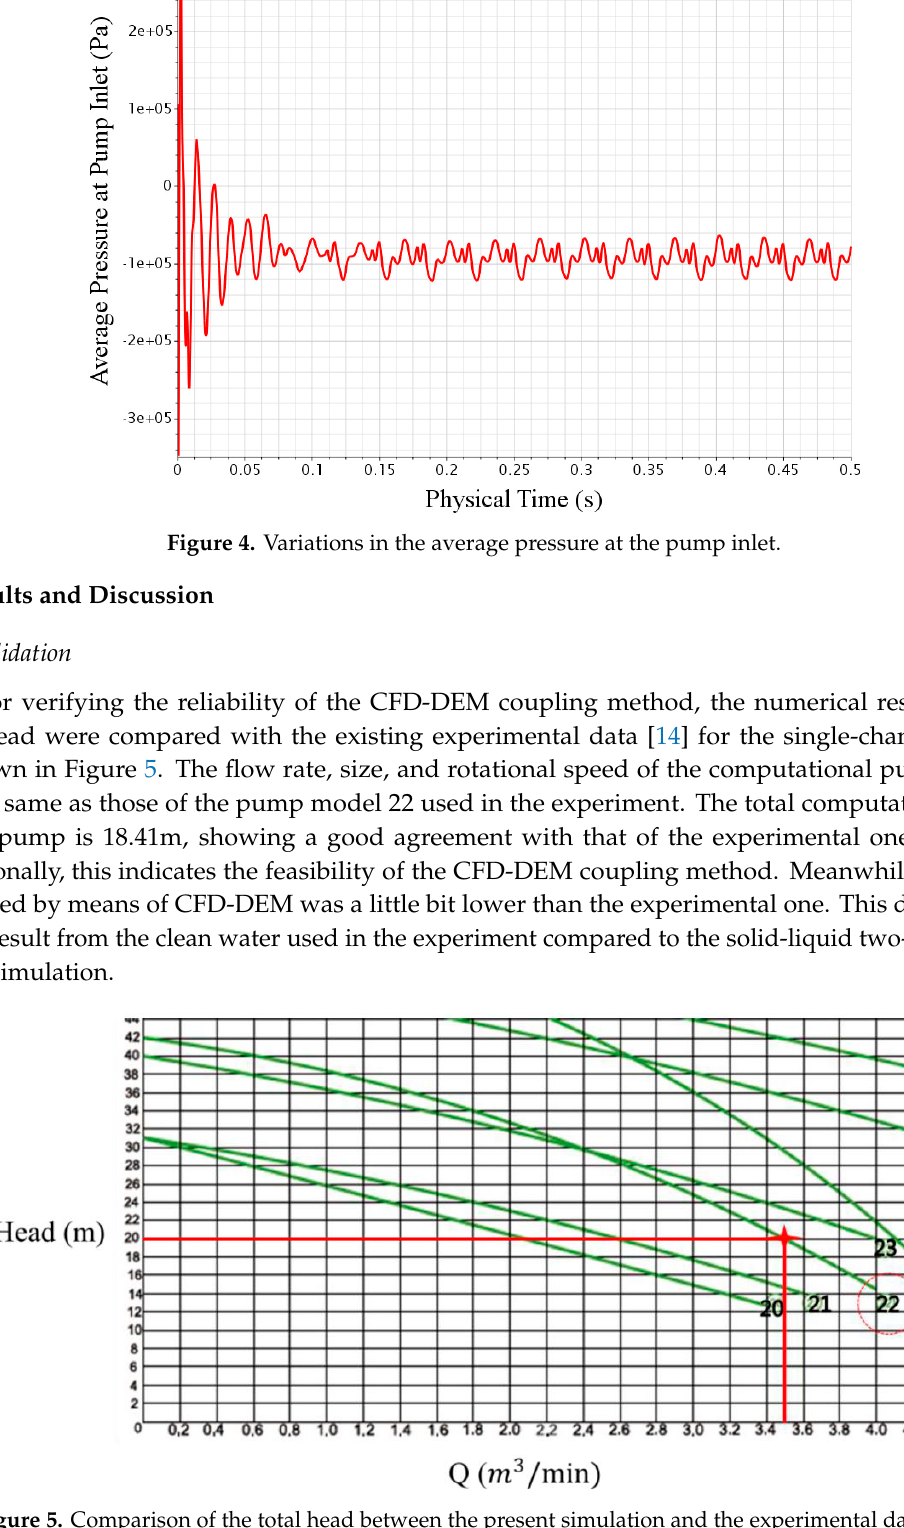
Figure 5. Comparison of the total head between the present simulation and the experimental data [12].